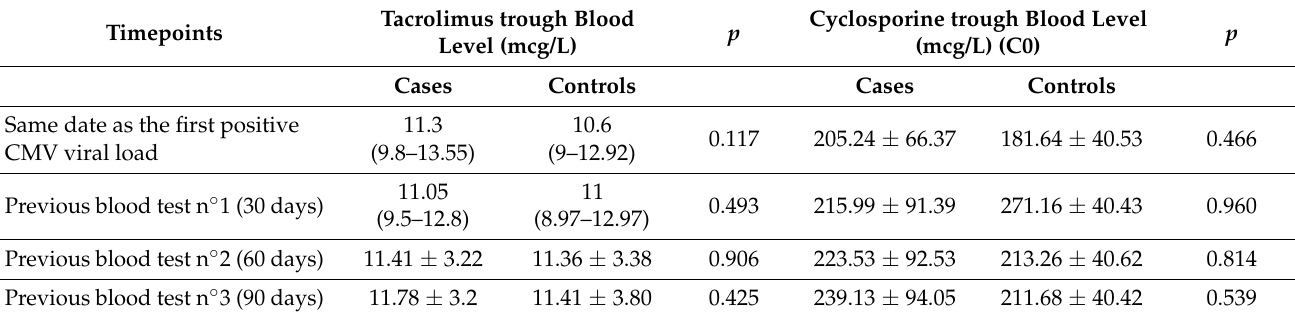
Table 2. Immunosuppressant blood levels and the first positive CMV viral load [1].